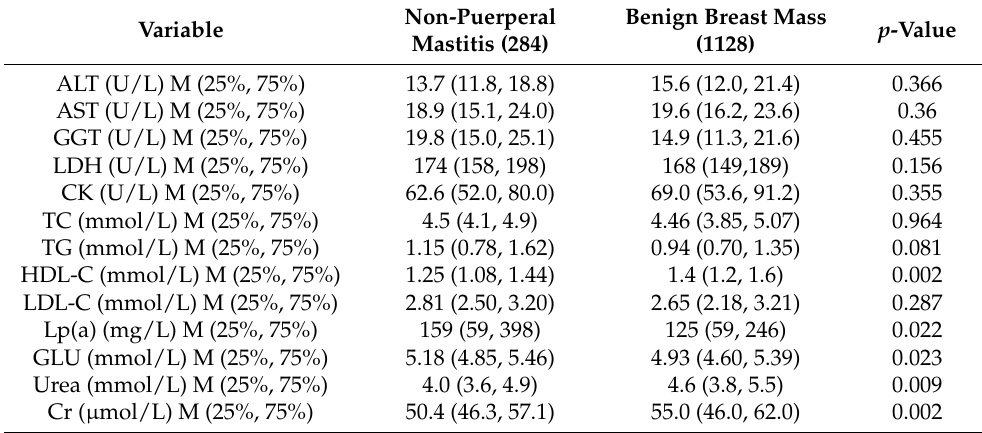
Table 1. The biomedical indicators of NPM and benign breast mass